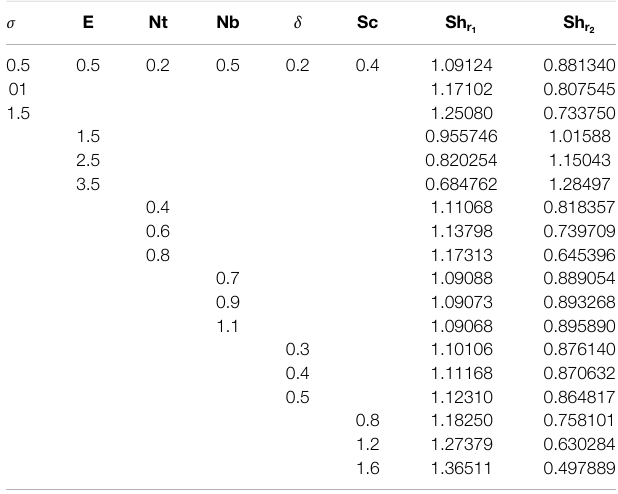
TABLE 4| Effect ofparameters σ , E , Nt , Nb , δ ,and Sc onlocalSherwood number Sh x .